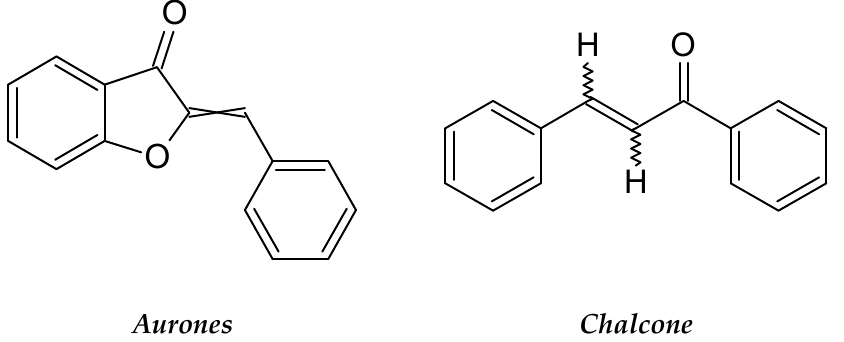
Figure 11. The structures of aurones and chalcone.